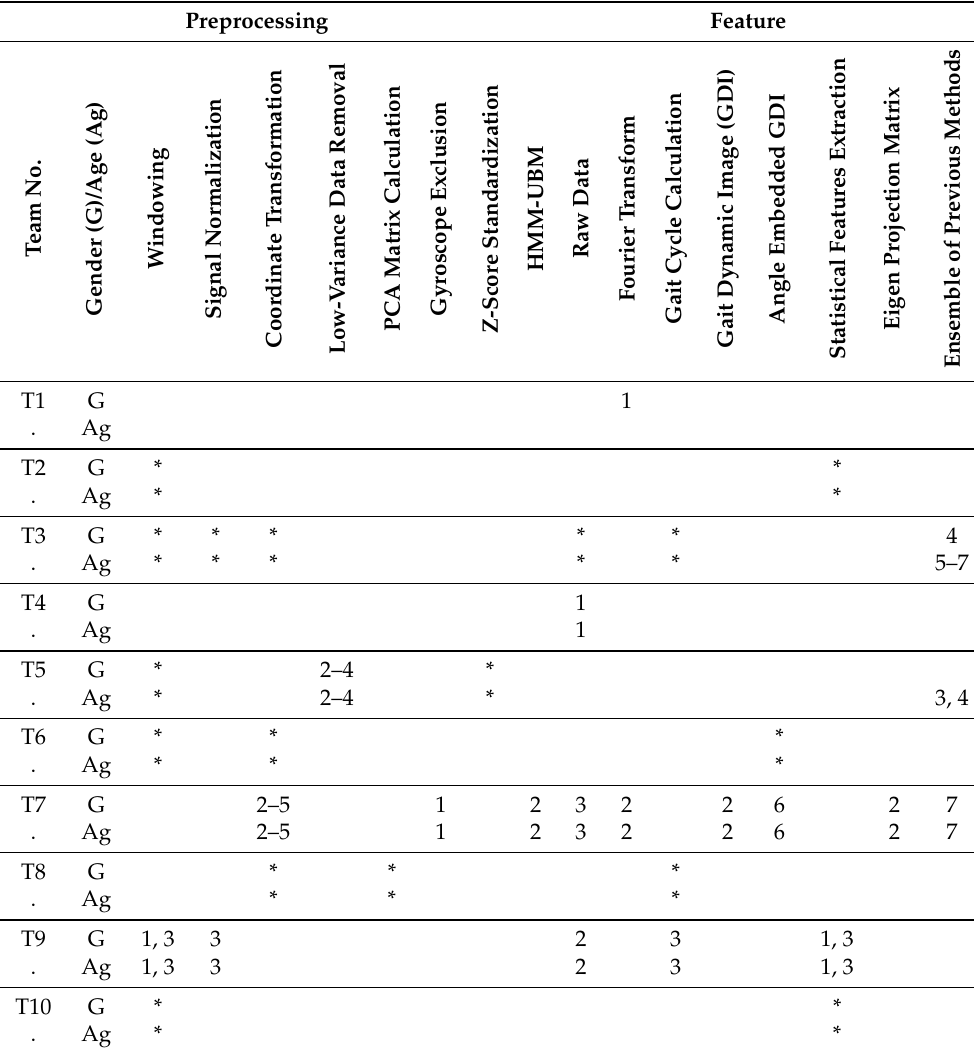
Table 4. Employed preprocessing and feature extraction approaches for gender (G) classification and age (Ag) prediction. ‘*’ denotes that all of their algorithms used the approach. Numbers represent the algorithm numbers (i.e., instead of ‘Alg.1’, ‘Alg.2’—we mention ‘1’,